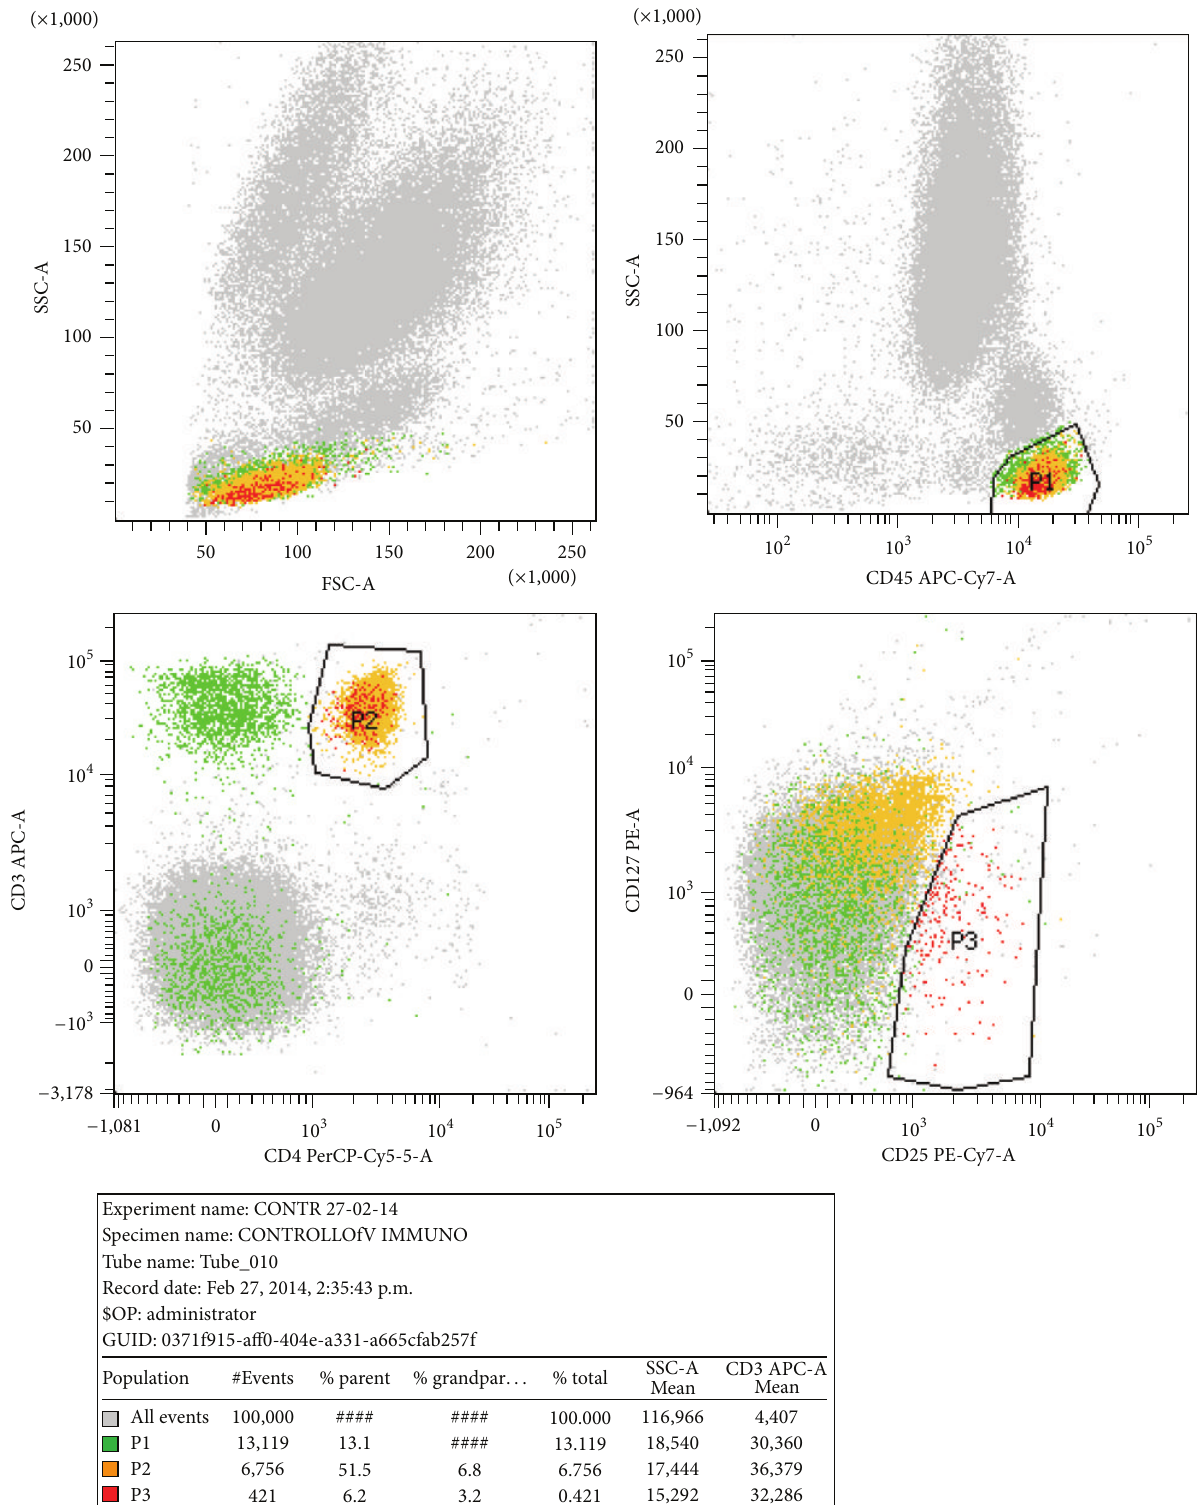
Figure 1: Flow cytometric analytical gating strategy. Tregs were evaluated, after selecting on gated CD45 + lymphocytes (P1), CD4 + cells (P2) as cells with CD25 + at high density and CD127 low density or undetectable levels